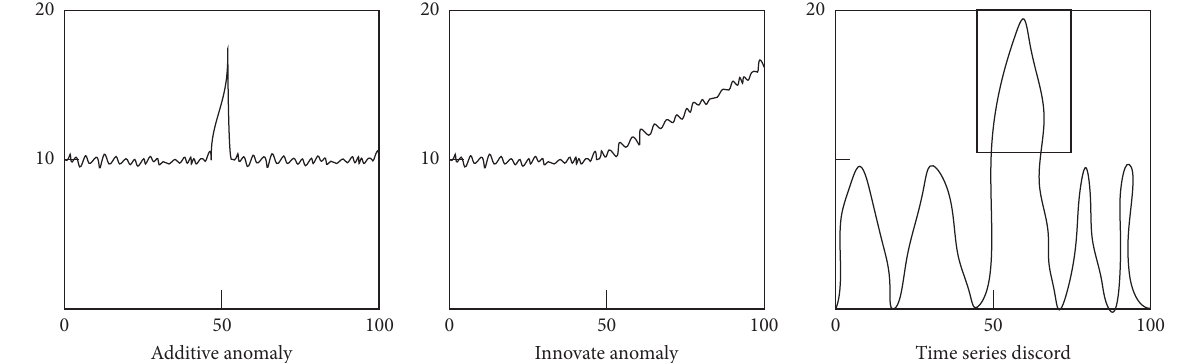
Figure 7: Tree diferent outliers.